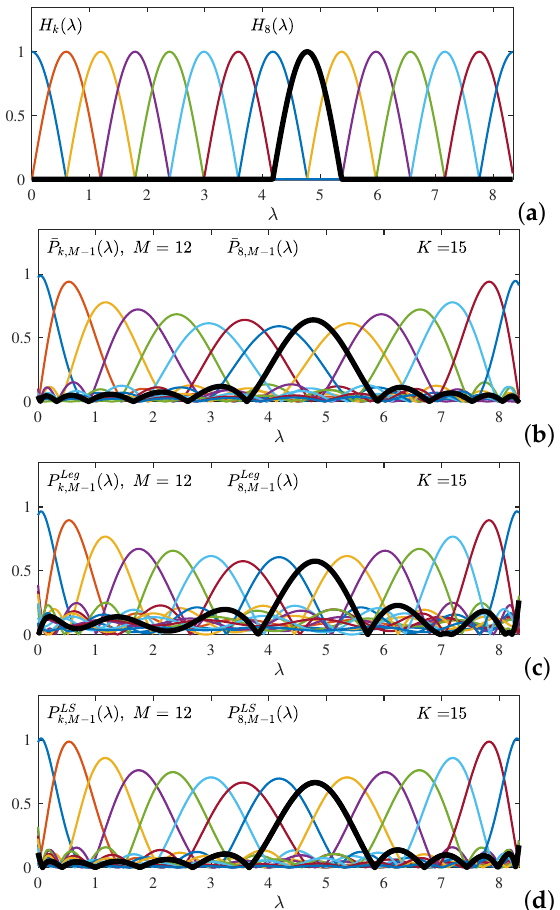
Figure 14. Spectral bandpass transfer functions used for calculation of the LGFT and their polynomial approximations. ( a ) Spectral functions of the Hann form with K = 15. ( b ) Approximation of spectral transfer functions based on Chebyshev polynomial with M = 12. ( c ) Legendre-polynomial-based approximations of spectral transfer functions with M = 12. ( d ) Least squares approximation of spectral transfer functions with M = 12. For convenience, function H 8 ( λ ) is designated with a thick black line on each